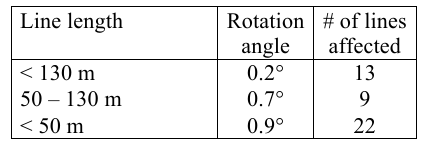
Table 1. Rotation angles for adapted line